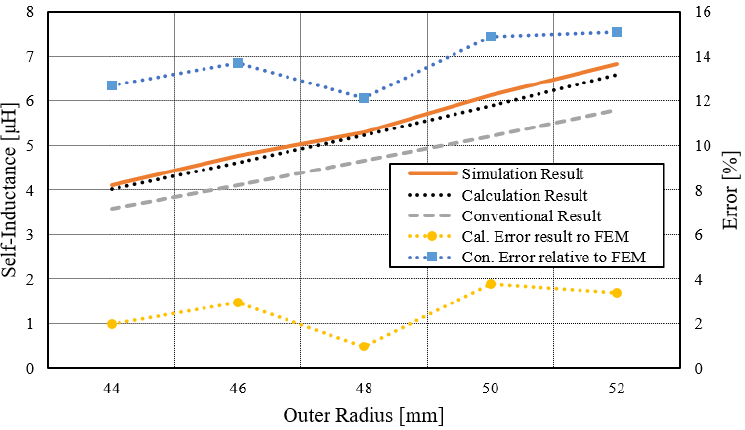
Figure 3. The behavior of the self-inductance of the spiral coil as a function of outer radius. One of the factors the inductance depends on is the size of the coil. As the size of the coil increases, the inductance also increases. The inductance obtained from